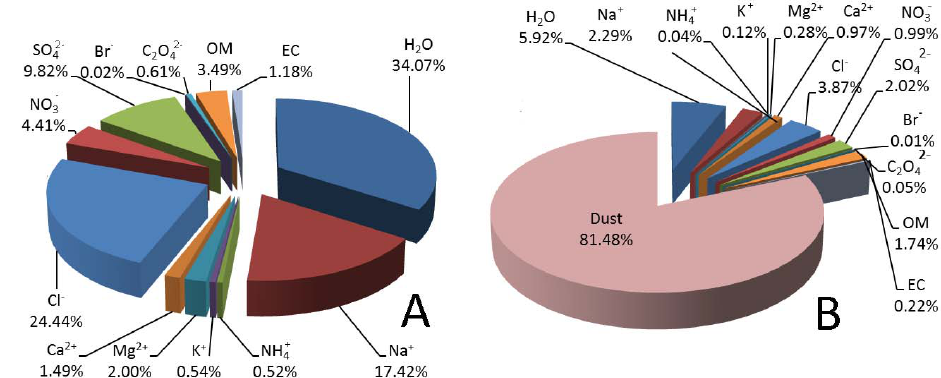
Figure 2. Averaged PM 10 constitution for 183 marine samples (a) and 49 mineral-dust-dominated aerosol samples (b) collected at 32m on top of the